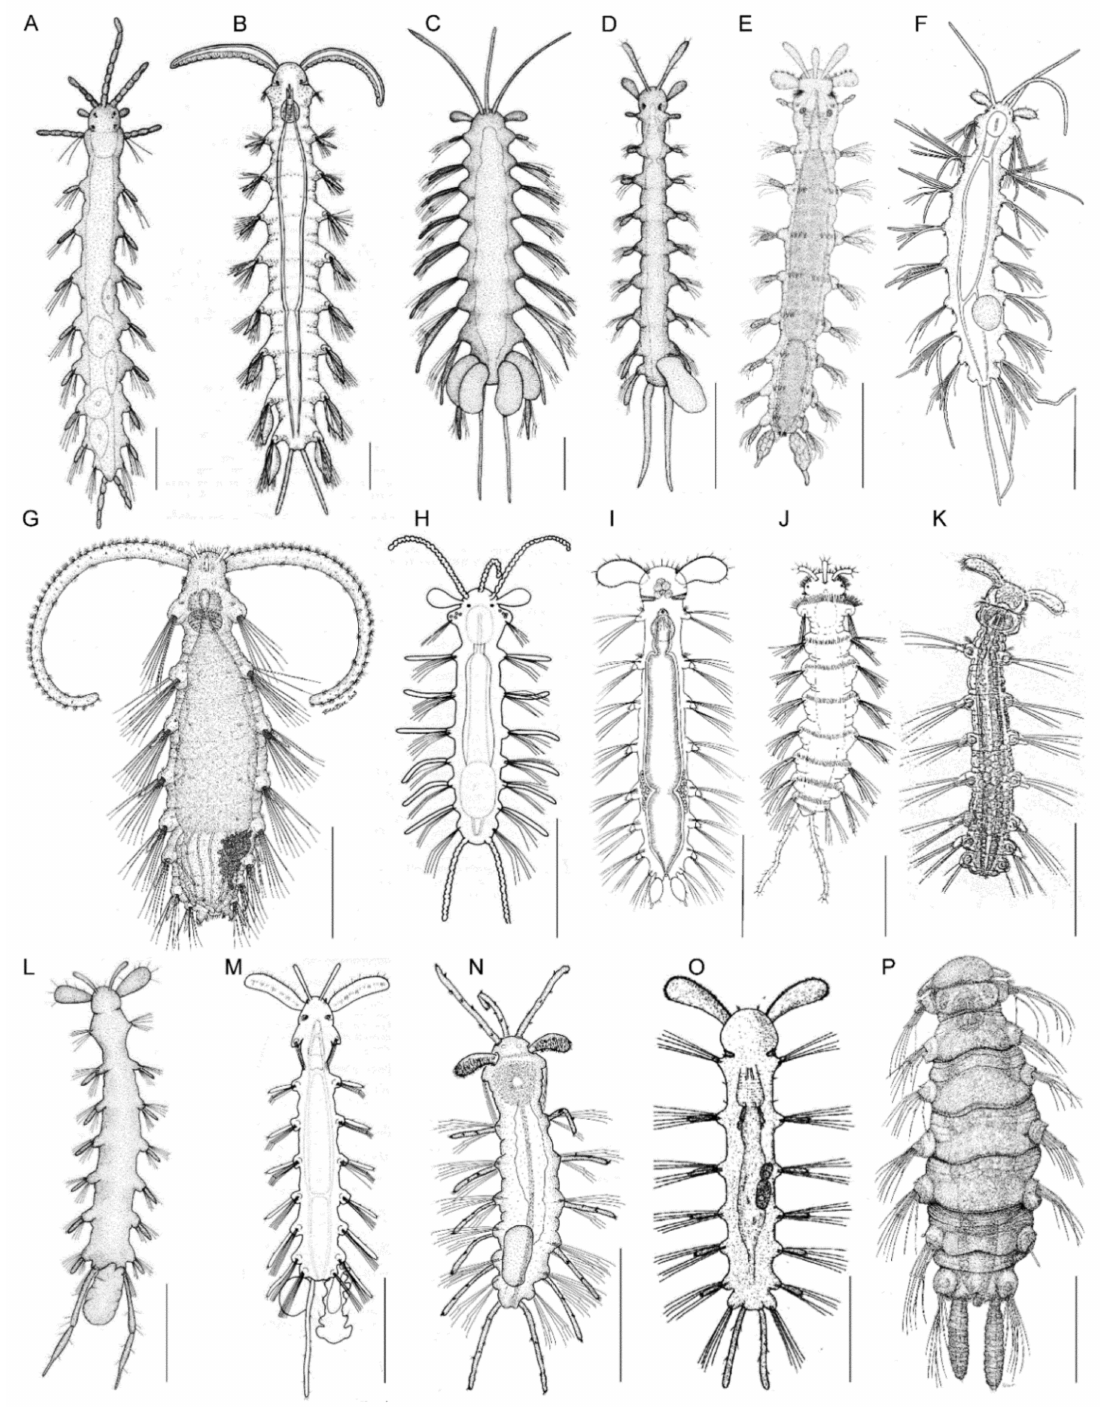
Figure 7. Schematic drawings of Nerillidae genera. ( A ) Nerilla antennata. ( B ) Meganerilla swedmarki. ( C ) Mesonerilla intermedia. (D ) Mesonerilla biantennata. ( E ) Mesonerilla armoricana. ( F ) Leptonerilla diplocirrata. ( G ) Speleonerilla saltatrix. ( H ) Micronerilla minuta. ( I ) Thalassochaetus palpifoliaceus. ( J ) Trochonerilla mobilis. ( K ) Troglochaetus beranecki. ( L ) Nerillidium mediterraneum. ( M ) Nerillidopsis hyalina. ( N ) Aristonerilla brevis. ( O ) Psammoriedlia ruperti. ( P ) Paranerilla cilioscutata. Scale bars 200 µ m; all dorsal view except for N (ventral view). Redrawn or modified from: ( A , C , D , L ), [129]; ( B ), [130], ( E ), [36]; ( F ), [127]; ( G ), [40]; ( H , M ), [53]; ( I ), [131]; ( J ), [132]; ( K ), [133]; ( N ), [134]; ( O ), [135]; ( P ), [33]—acknowledging copyright permissions granted by the